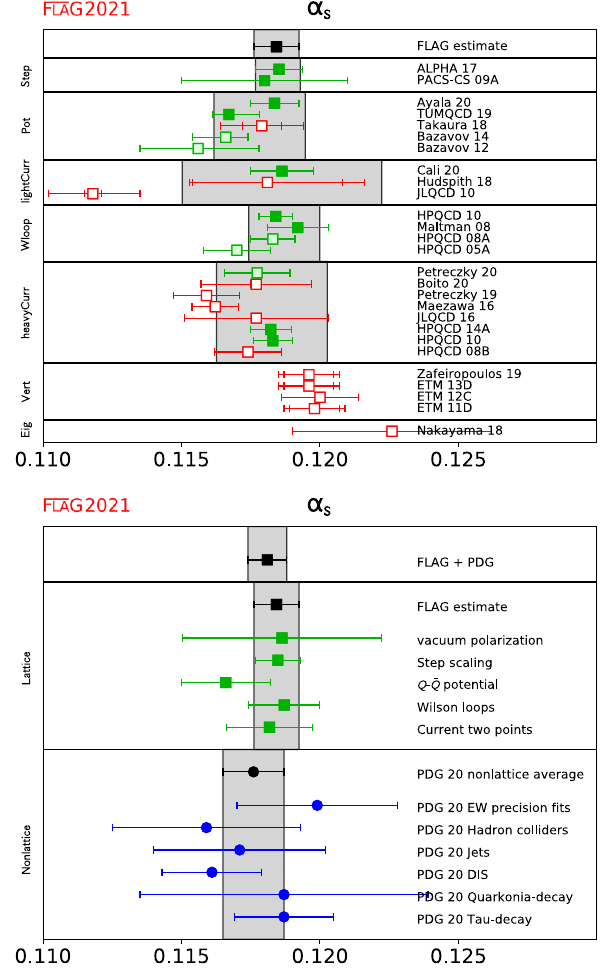
( M ) , the coupling constant in the MS scheme at the Z mass. Top: lattice results, pre-ranges from different calculation methods, and Fig. 41 α ( 5 ) Z MS final average. Bottom: Comparison of the lattice pre-ranges and average with the nonlattice ranges and average. The first PDG 20 entry gives the outcome of their analysis excluding lattice results (see Sect.